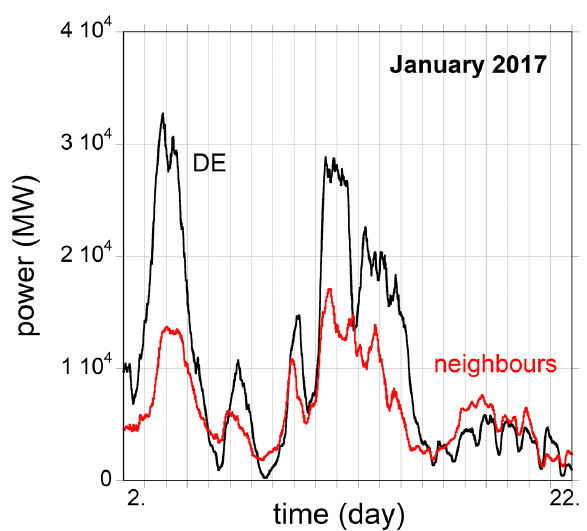
Fig. 10. – Onshore wind power generation of Germany and, in the sum, of its 9 neighbours for January